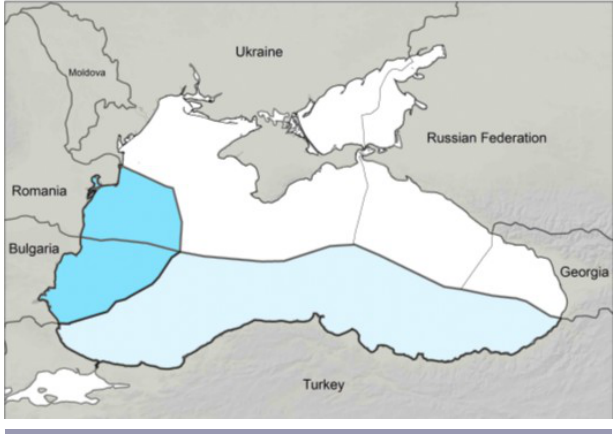
Fig. 1 . Map of the Black Sea region showing the riparian states and exclusive economic zones. Waters under the jurisdiction of the European Union (EU) are shown in blue. The exclusive economic zone for Turkey, a candidate for accession to the EU, is shown in pale